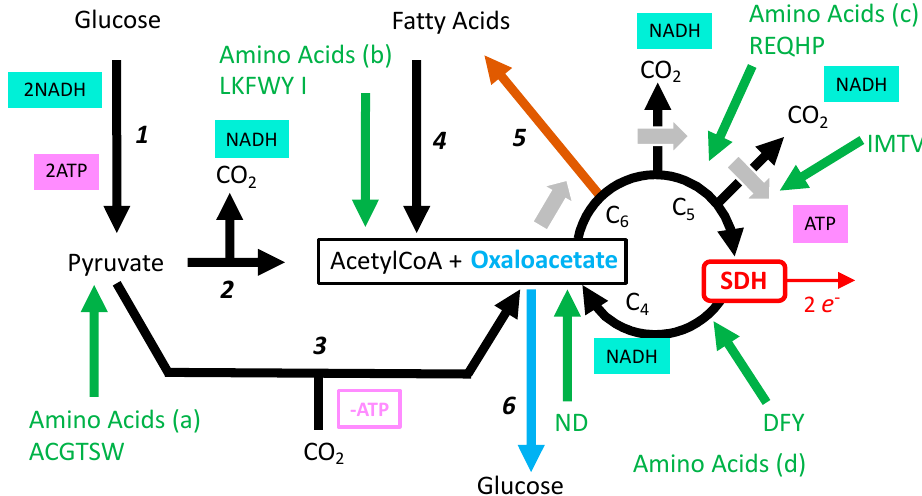
Figure 8. Interconnection of TCA with the rest of oxidative metabolism. 1: Glycolysis, 2: pyruvate dehydrogenase, 3: pyruvate carboxylase, 4: fatty acid oxidation, 5: fatty acid synthesis (lipogenesis), 6: gluconeogenesis, green arrows: different entries for the oxidation of the carbon skeleton of amino acids are shown with positions as relevant here (a–d), green capital letters refer to one letter amino acid